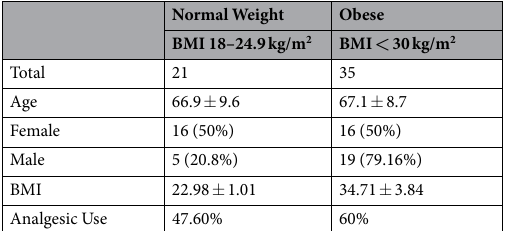
Table 2. Patient Demographic